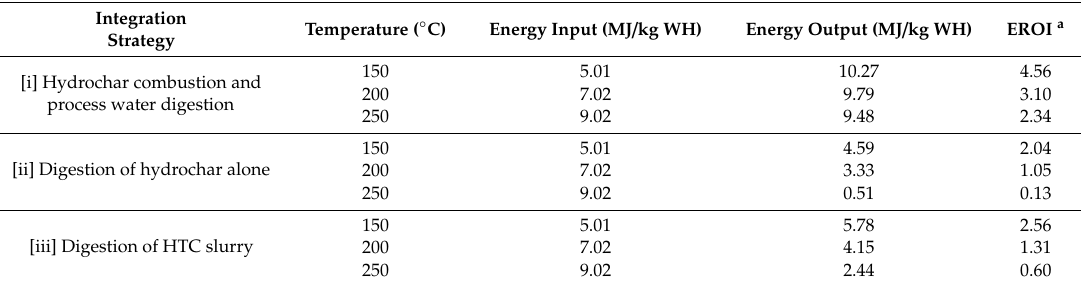
Table 7. Energy balance for the integration strategies for hydrothermal carbonisation and anaerobic digestion using a starting material of 1 kg of dried water